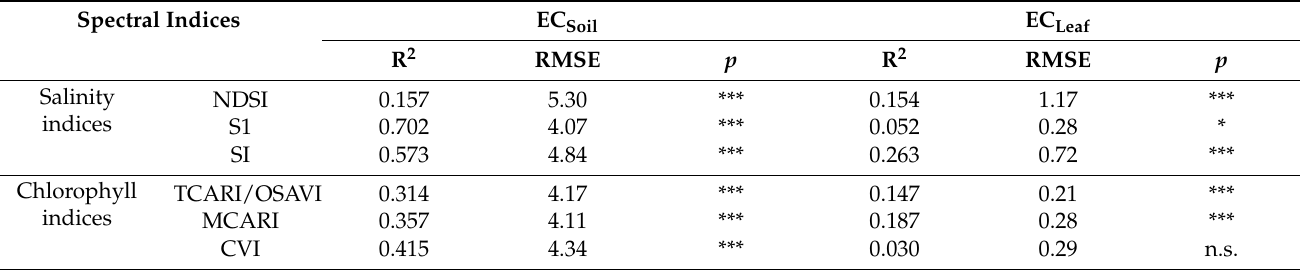
Table 6. Coefficient of determination (R 2 ), root-mean-square error (RMSE), and p -level statistical significance for soil (EC Soil ) and leaf (EC Leaf ) electrical conductivity and spectral indices derived from Sentinel-2 multispectral